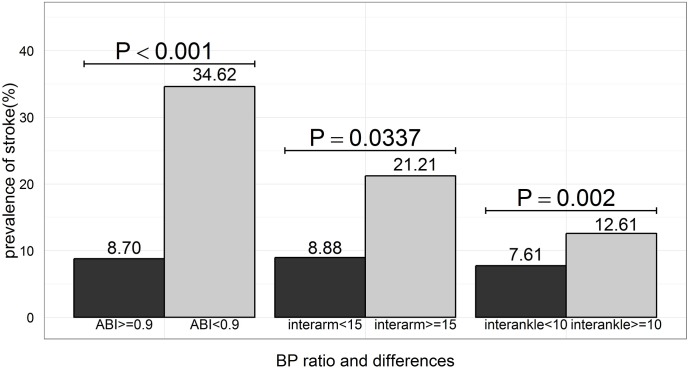
Prevalence of stroke stratified by the ankle-brachial blood pressure index (ABI) and interarm and interankle blood pressure (BP) differences.The prevalence of stroke was stratified according to the ABI (≥0.9 vs. <0.9, left) interarm BP difference (<15 mmHg vs. ≥15 mmHg, middle), and interankle BP difference (<10 mmHg vs. ≥10 mmHg, right). The p-value (Chi-square test) is given for each comparison. Numbers above the bars are rates of prior stroke.